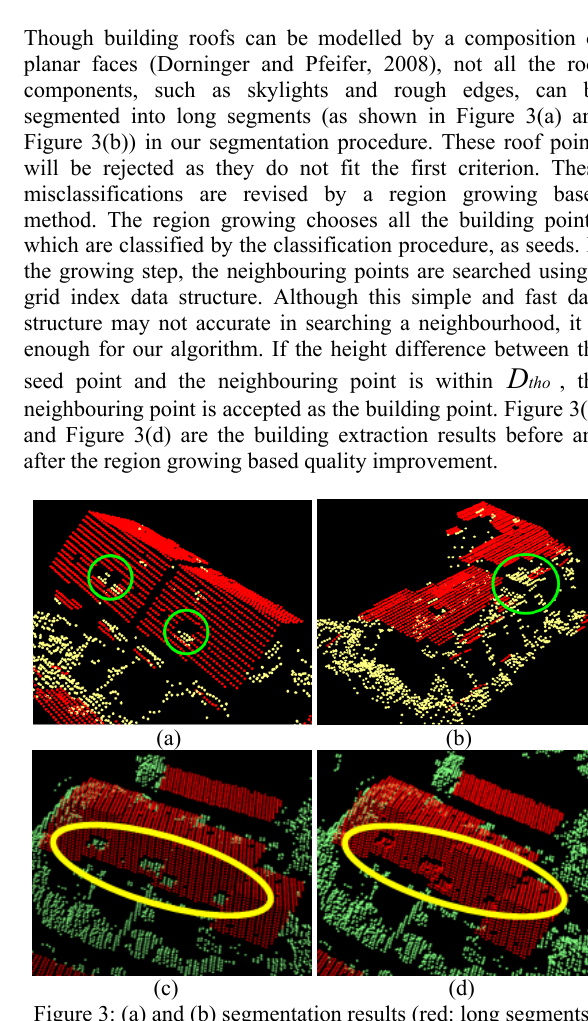
Figure 2: Scan line segmentation results, (a) segmentation result of a scan line; (b) segmentation result of a test area (different colors label different segments, 3D view).